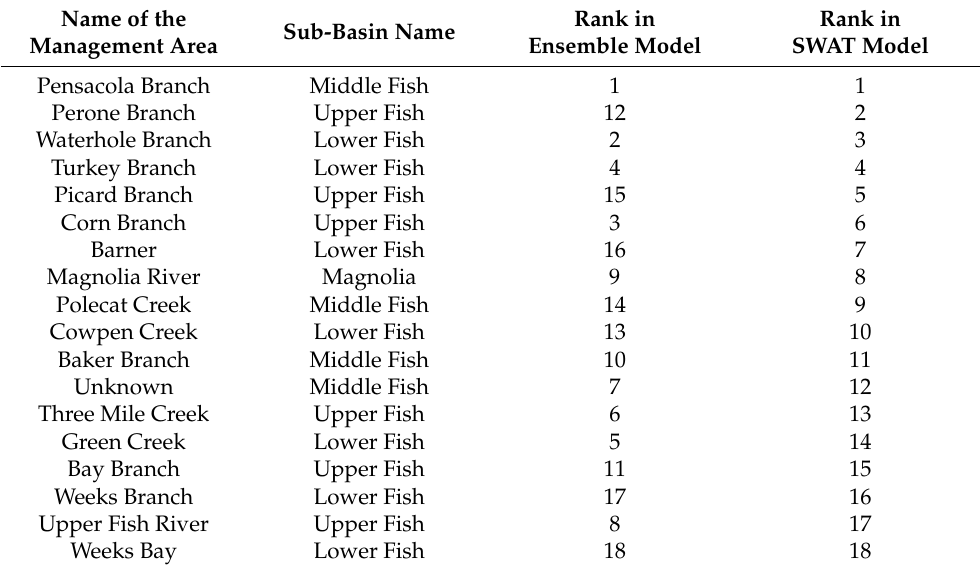
Table 5. Weeks Bay management area rankings from ensemble model and SWAT